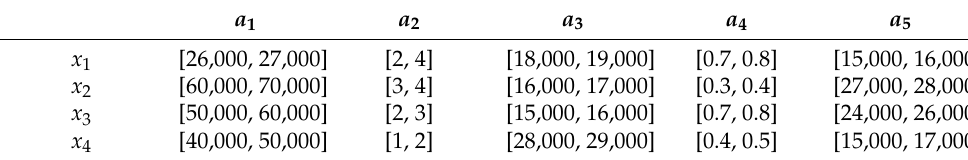
Table 5. Decision matrix.